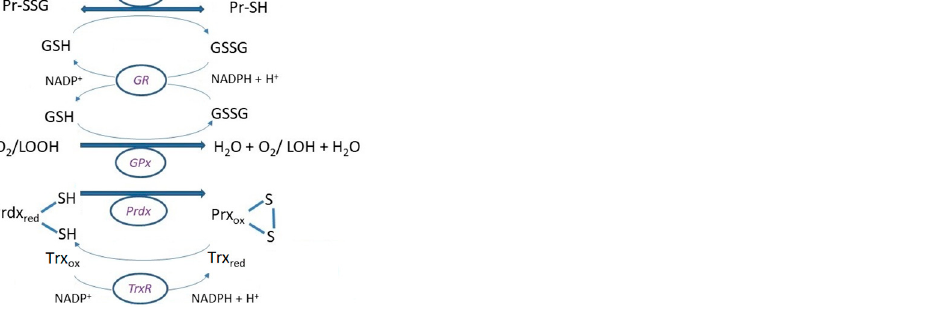
Figure 3. Basic reaction mechanisms of glutathione peroxidase (GPx), and glutaredoxin in (de)glutathionylation using (GSH)GSSG, respectively, and reduction of GSSG by the activity of glutathione reductase (GR) with reducing the power of NADPH + H + . Reduction of peroxiredoxin (Prdx) after disposal of peroxides is ensured by thioredoxin (Trx), which is reduced by consumption of NADPH + H + in catalytic efficiency of thioredoxin reductase (TrxR).